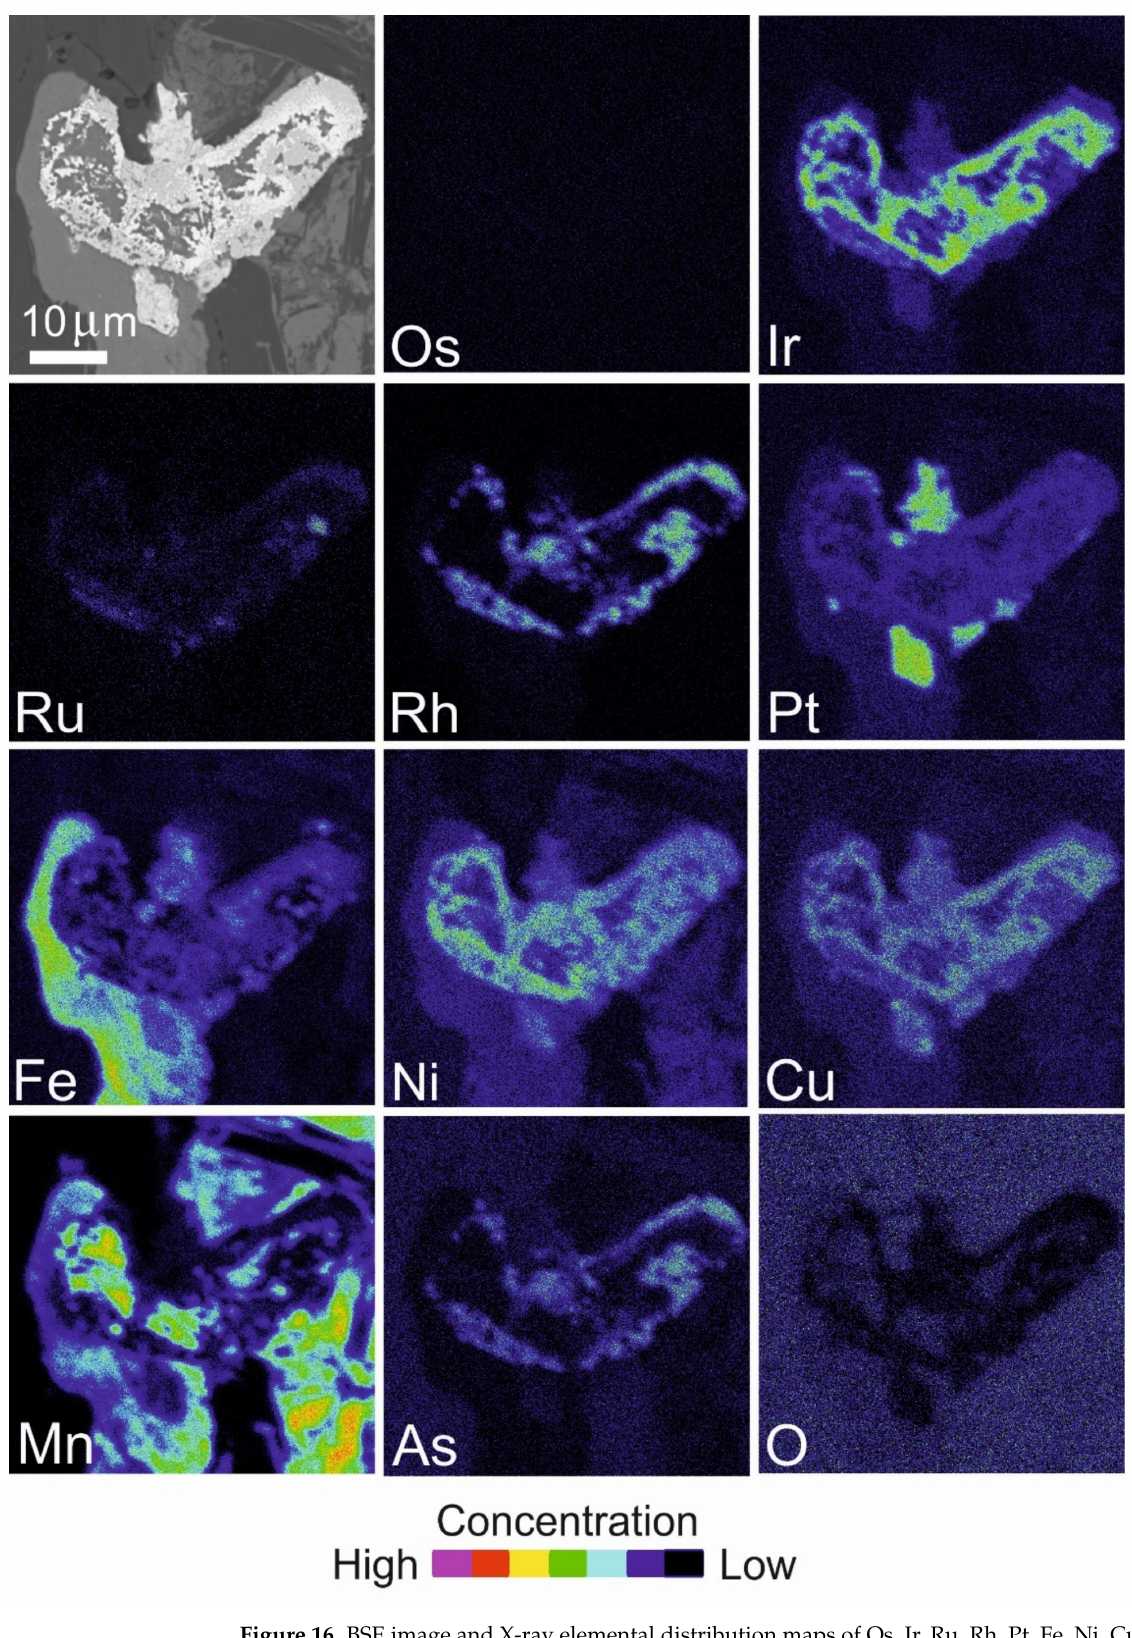
Figure 16. BSE image and X-ray elemental distribution maps of Os, Ir, Ru, Rh, Pt, Fe, Ni, Cu, Mn, As and O in the PGM shown in Figure 14C,D composed of garutiite–iridium–zaccariniite and a Pt